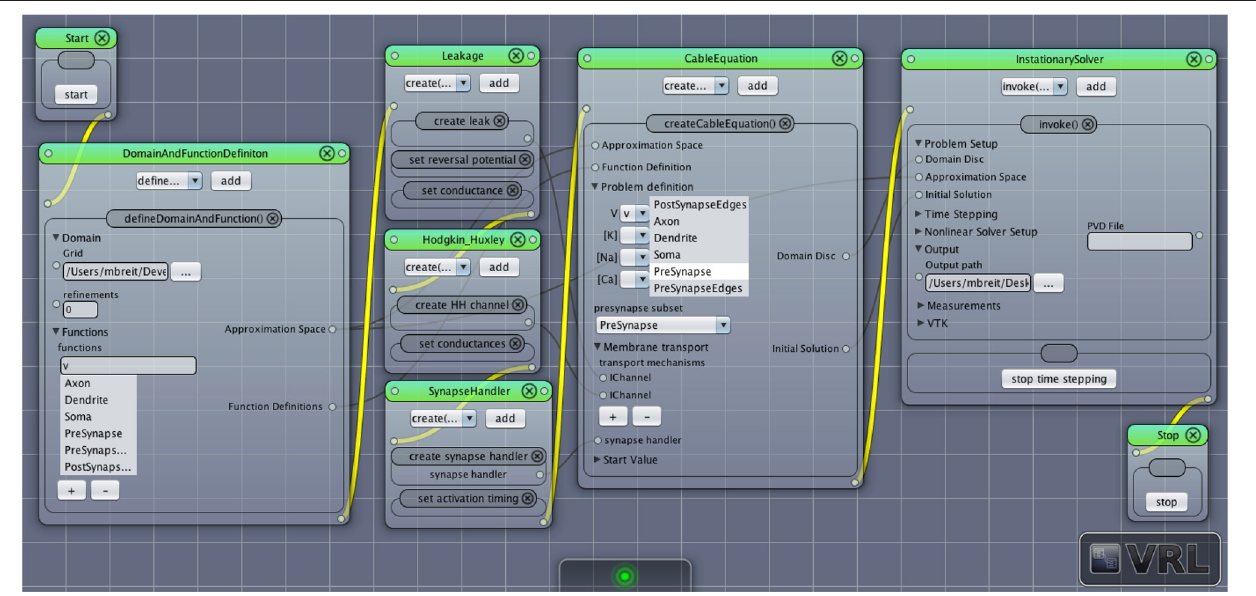
FIGURE 6 | Screenshot of a simple network simulation workflow assembled in VRL-Studio. Each window represents an object, the named panels in the window represent a method call with the contents of the panel as parameters. The control flow is defined by the yellow connections, data transfer between objects is marked by gray